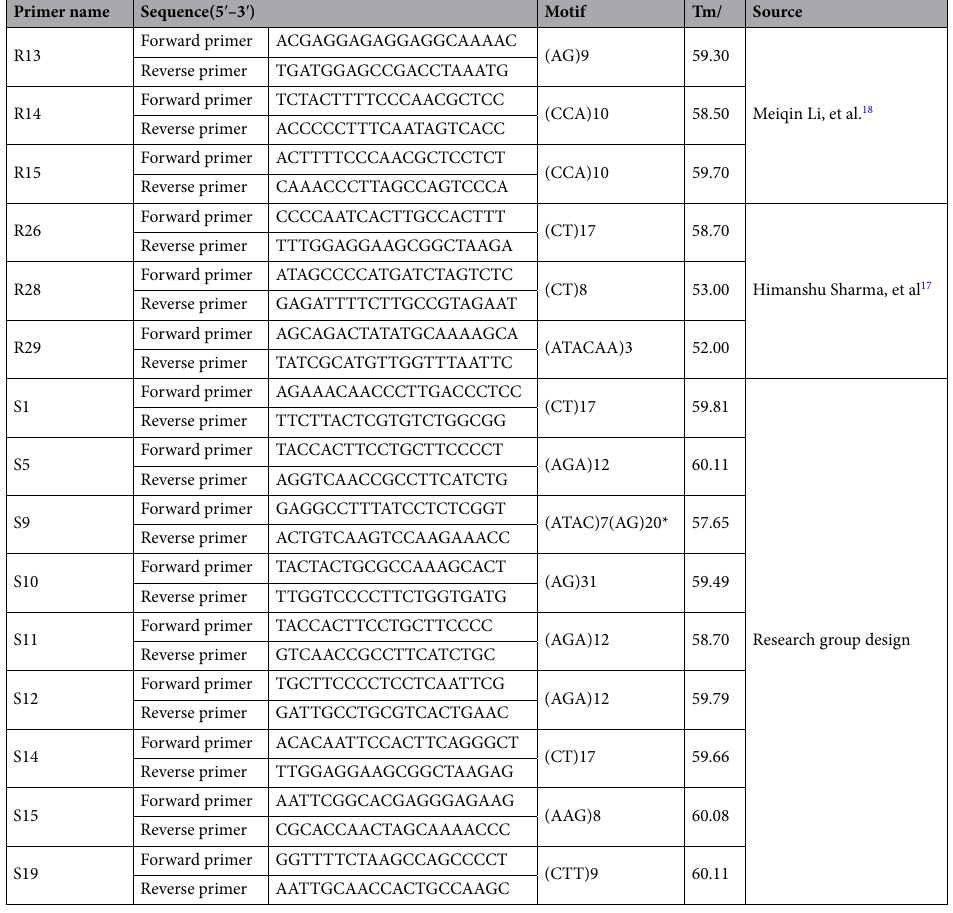
Table 3. Primer information EST-SSR 15 pairs of azalea.